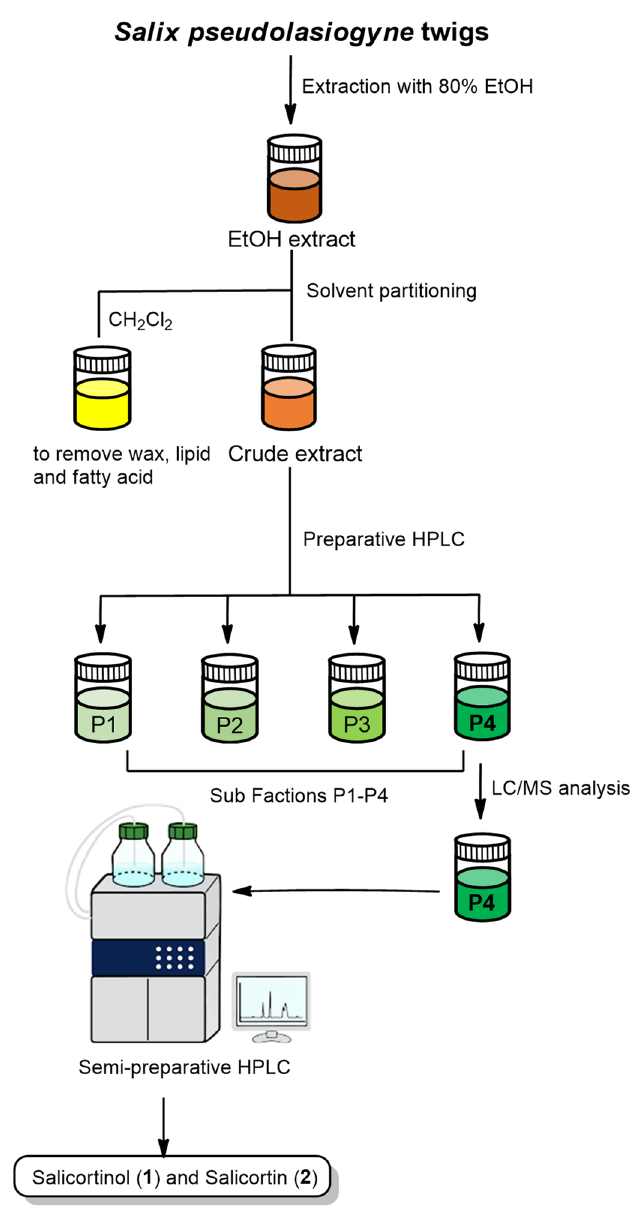
Figure 1. Separation scheme leading to salicortinol and salicortin identification.